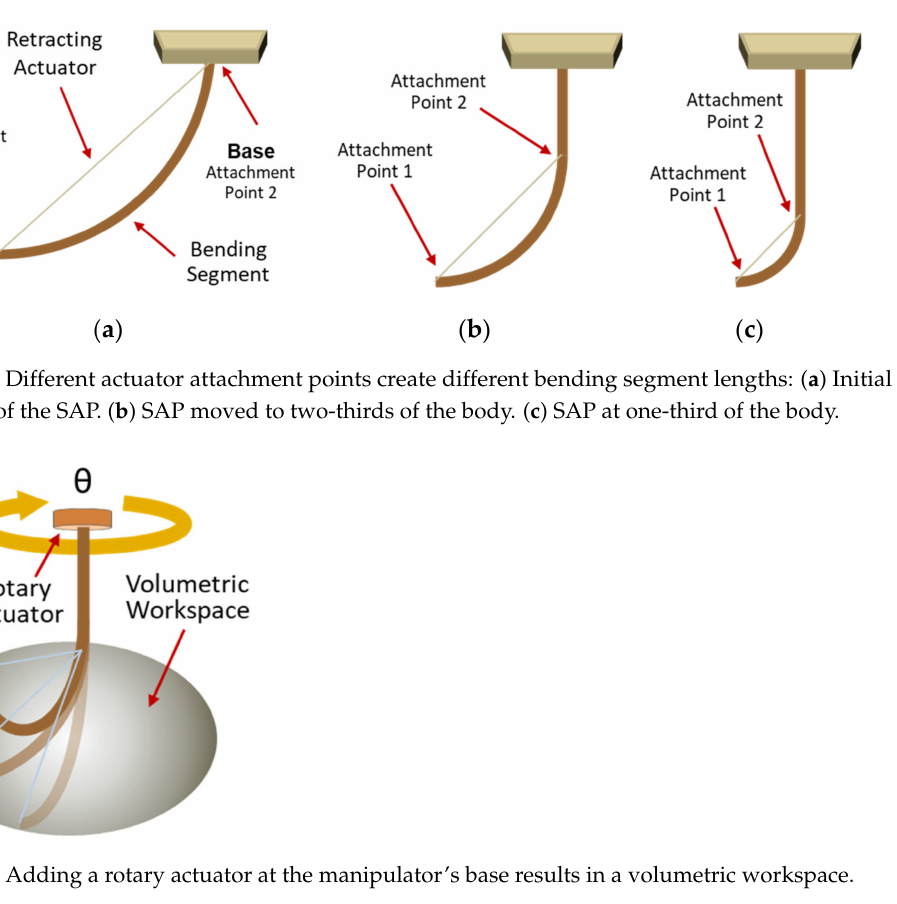
Figure 1. The SCRaM’s tip follows a path as the linear actuator retracts.